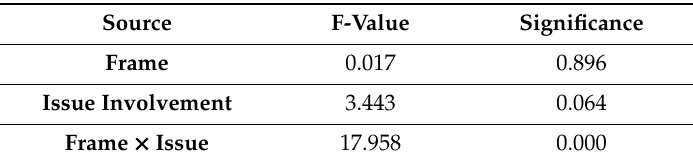
Table 5. Results of ANOVA (frame and issue involvement).